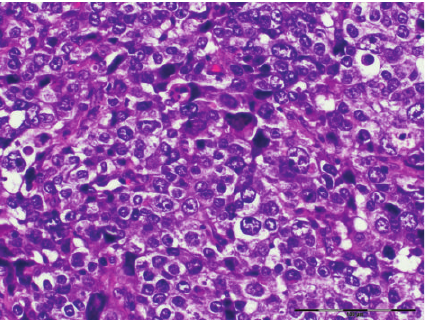
Figure 1: Lung lobectomy: hematoxylin and eosin stain of the pathologic specimen from left upper lobectomy showing poorly differentiated adenocarcinoma, H&E.